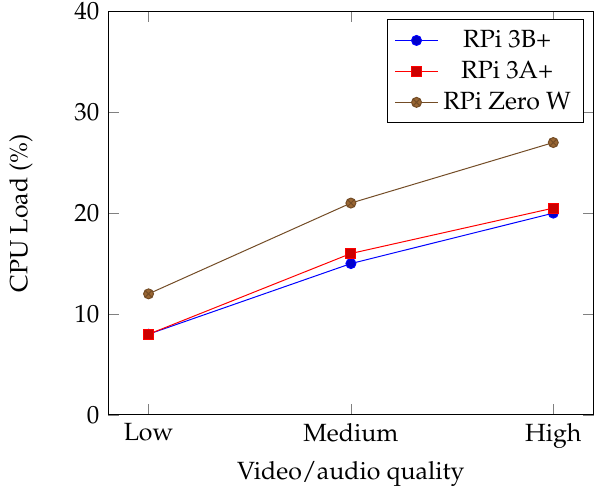
Figure 6. Processing power